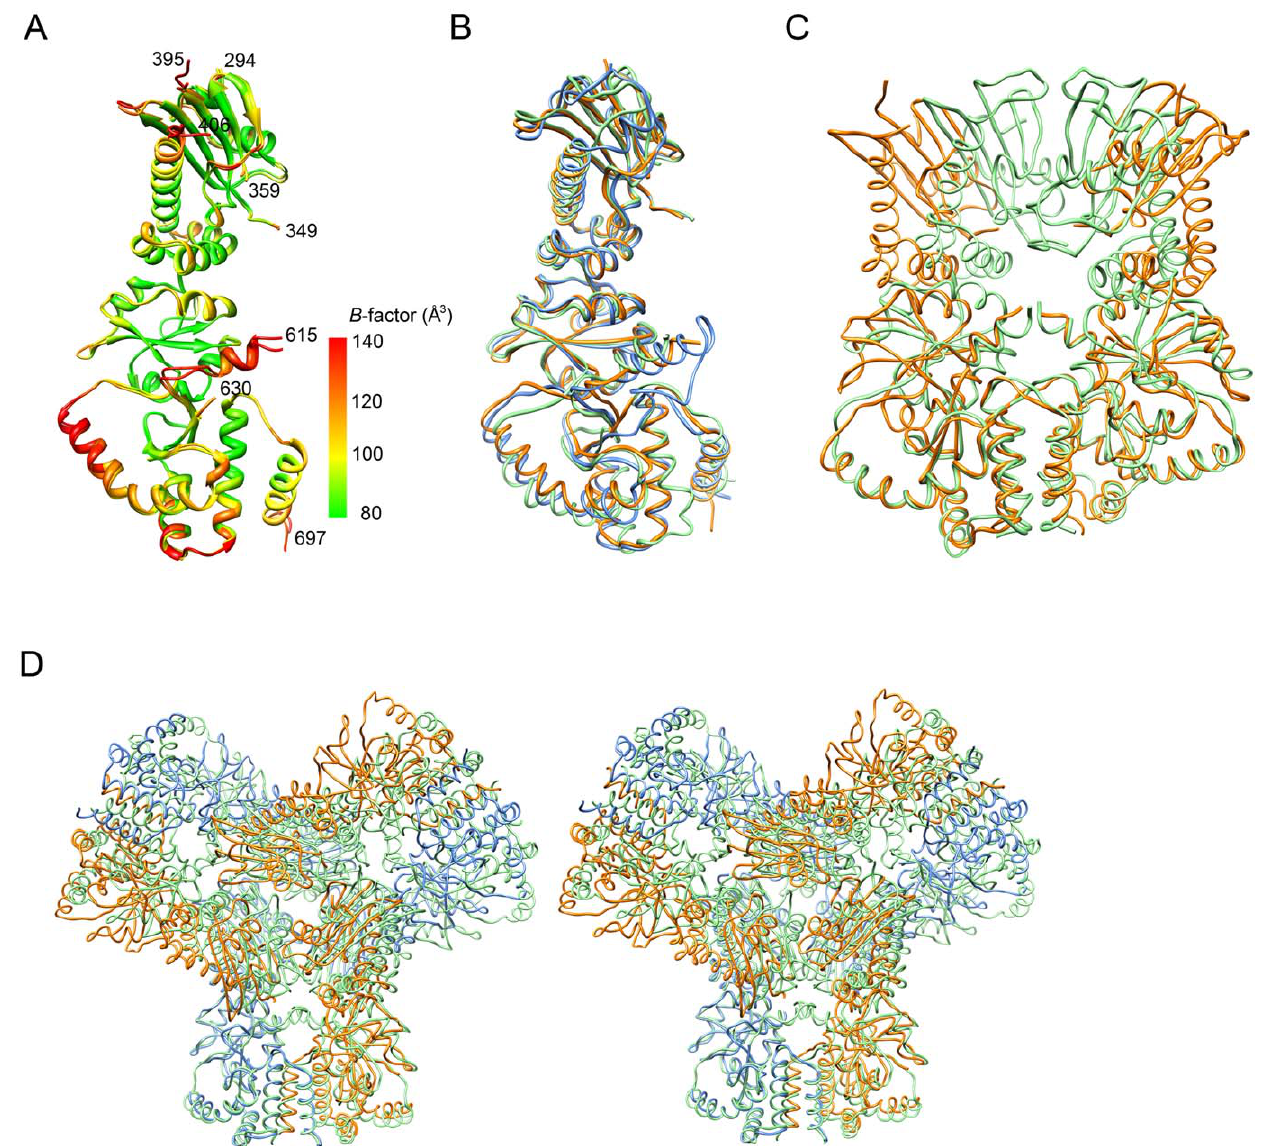
Figure 3. Comparison of HSP90 structures. (A) Disordered regions of MC-HSP90. The protomers A and B in the C 222 1 crystal are superimposed with RMSD of 0.637 A˚ between 367 C a atom pairs. The residue number of N- and C-termini and the terminal ends of disordered loops in protomer A are indicated. The protein models are presented with ramped colors according to the B values. The start of the curved a -helix ( a 9) and the extended arm ( a 10) at C domain show high temperature factors. (B) The monomer structure of human MC-HSP90 (orange) is superimposed on the MC domains of closed-form yeast HSP82 (green) and open-form canine GRP94 (blue). (C) The dimer structure of human MC-HSP90 (orange) is superimposed on the MC domains of close-form yeast HSP82 (green). (D) Stereo view of superposed hexameric structures. The human MC-HSP90 hexamer and the N- terminal truncated yeast HSP82 (PDB: 2CGE) hexamer are superimposed. The protomers of Human MC-HSP90 dimer are colored in blue and orange, respectively, and six protomers of yeast HSP82 are colored in green. See Video S1 for more comprehensive